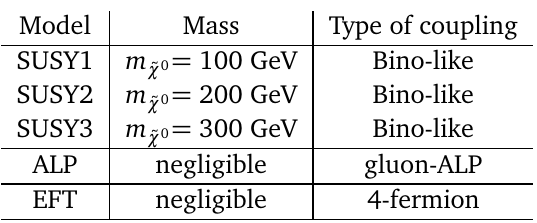
Table 1: Summary of benchmark